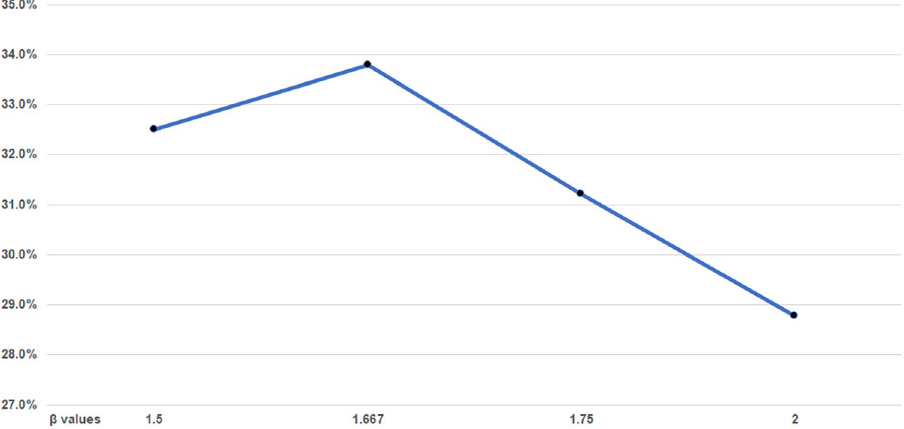
Fig 2. Destination prediction accuracy for different values of β in ^ mFI ^